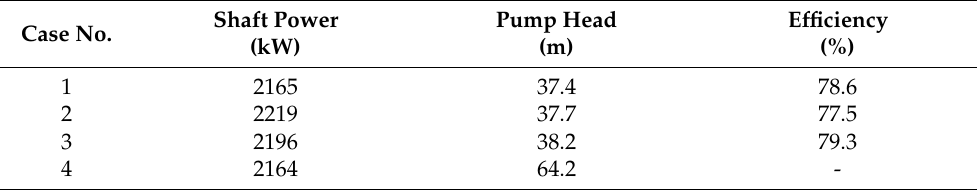
Table 4. Pump performance as installed in different sump geometries.